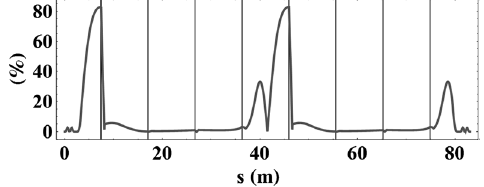
FIG. 5. Quantitative measure of the longitudinal/transverse bunching along the dogleg, defined as the first-order amplitude j ˆ ρ ð 1 Þ j =n 3 d as calculated from Eq. (9) and the DL1 lattice functions. The quantity plotted here measures the contrast in the density of the diagonal bands observed e.g., in Fig. 4. The vertical lines mark the location of the quadrupoles. Longitudinal/ transverse bunching requires finite dispersion η x but it is exponentially suppressed at points where the dispersion becomes ~ β = ε k 2 . too large η 2 x ≳ x x